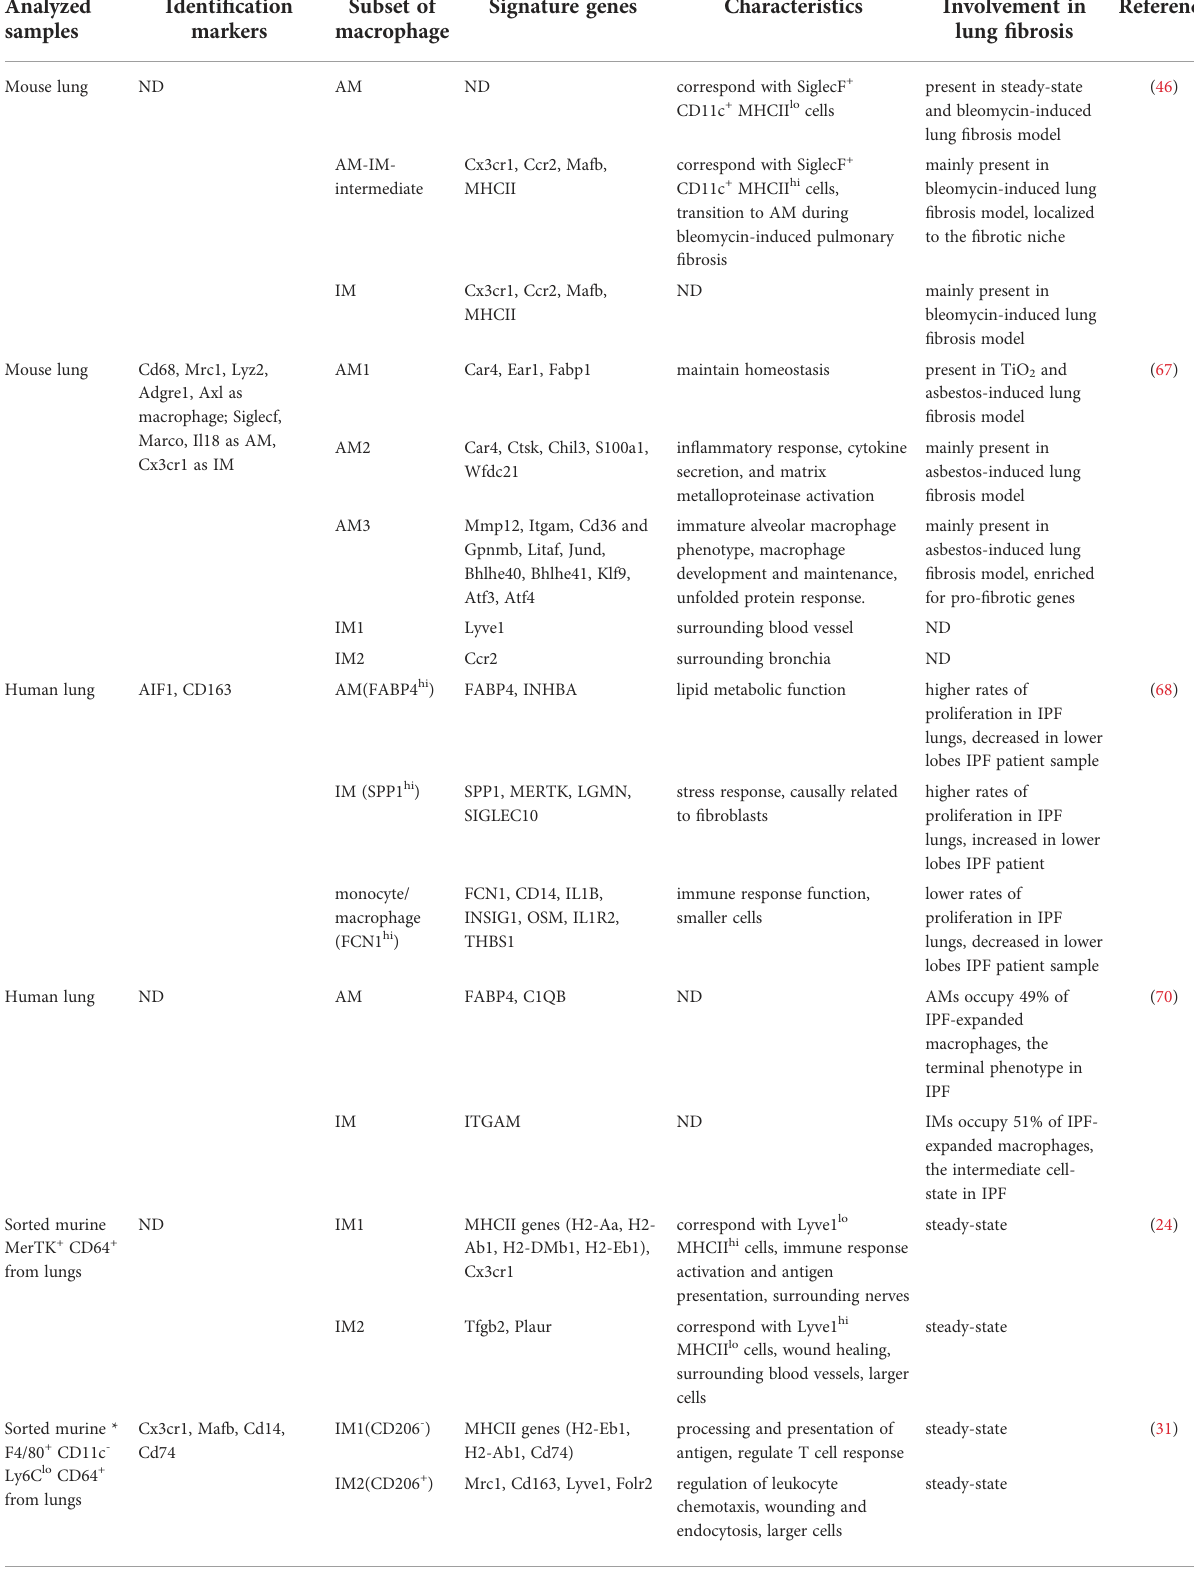
TABLE 3 scRNA sequencing for lung macrophage clustering in lung fi brosis and